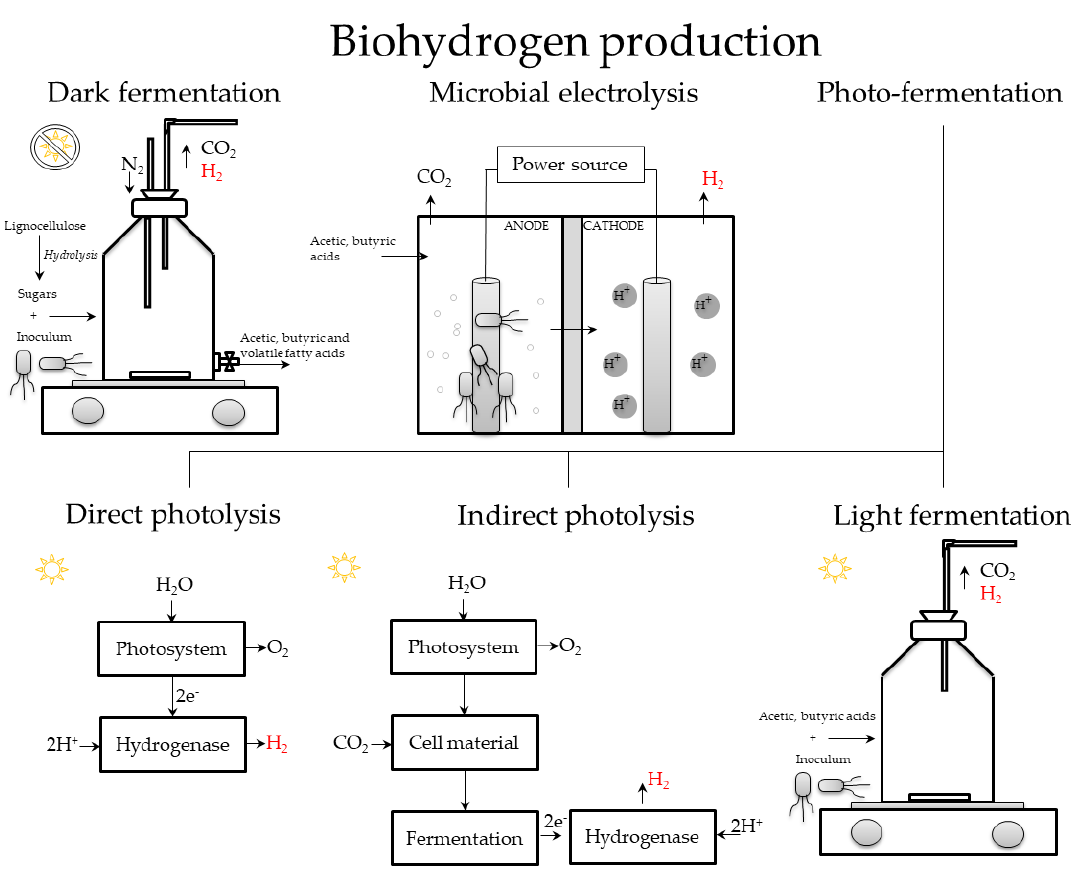
Figure 3. Different BioH 2 production processes.